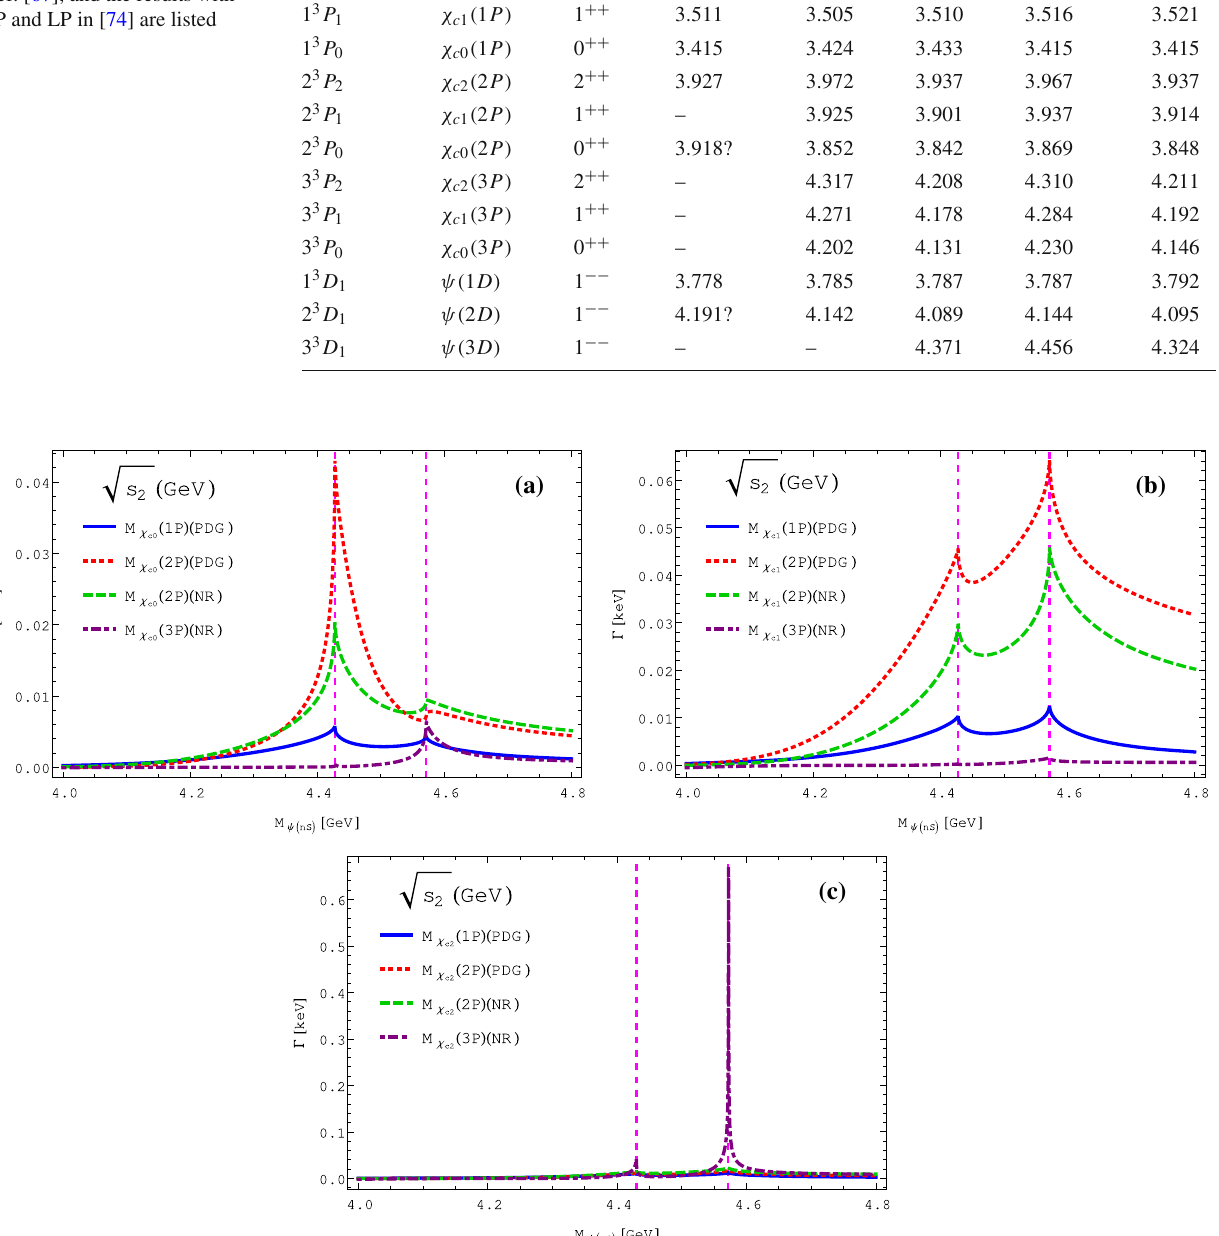
+ ∗ ( 2317 ) + D ∗− ( 2460 ) D ∗− s and D s threshold, s 1 s 0